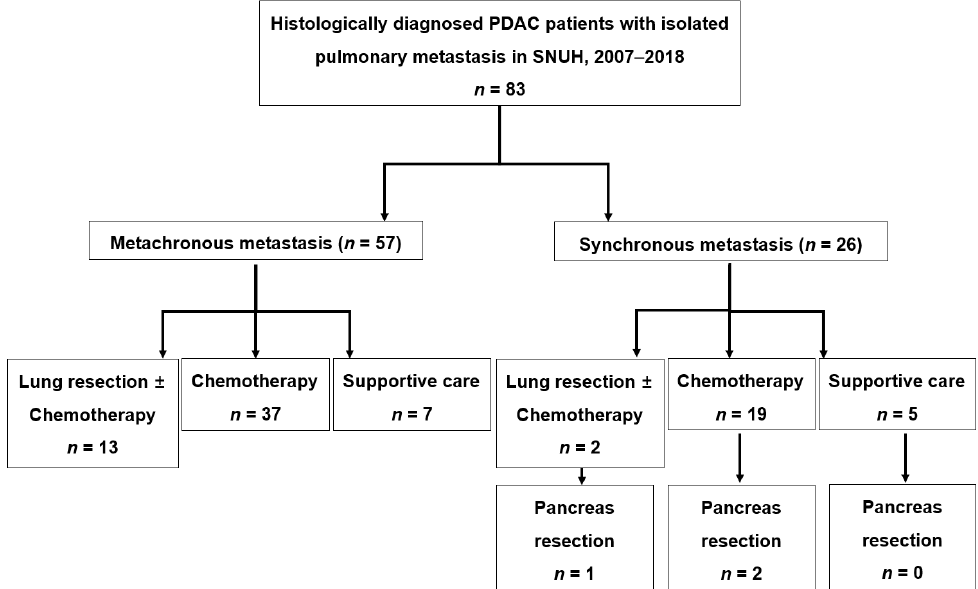
Figure 1. Flow diagram of the study with 83 patients who were histologically diagnosed as having pancreatic ductal adenocarcinoma with isolated pulmonary metastasis between January 2007 and December 2018.